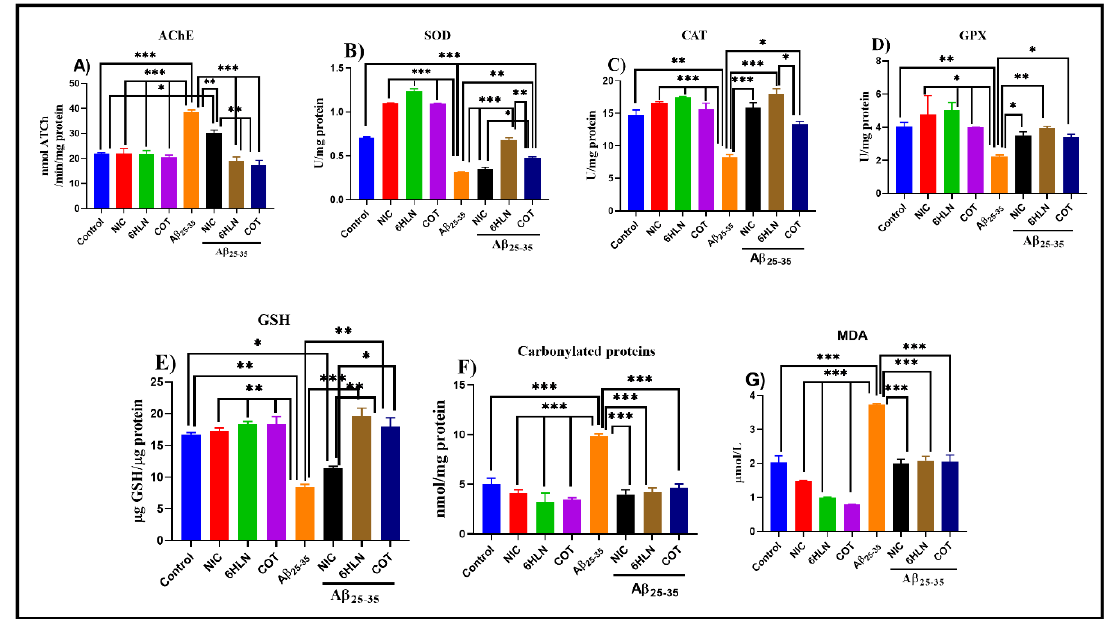
Figure 7. Effects of NIC, 6HLN and COT (0.3 mg/kg, b.w., i.p.) administration in Aβ 25-35 -treated rats on ( A ) AChE-specific activity and oxidative status, represented by ( B ) SOD, ( C ) CAT and ( D ) GPX-specific activities along with the content of ( E ) GSH, ( F ) carbonylated proteins and ( F ) MDA in the hippocampus. Values are expressed as means ± S.E.M. ( n = 6 animals per group). ANOVA analysis revealed overall significant differences between groups in ( A ) F(4,10) = 48.92, p < 0.0001, ( B ) F(4,10) = 100.7, p < 0.0001, ( C ) F(4.10) = 30.49, p < 0.0001, ( D ) F(4,10) = 18.15, p < 0.0001, ( E ) F(4,10) = 30.06, p < 0.0001, ( F ) F(4,10) = 32.55, p < 0.0001 and ( G ) F(4,10) = 26.87, p < 0.0001. For Tukey post hoc analyses –